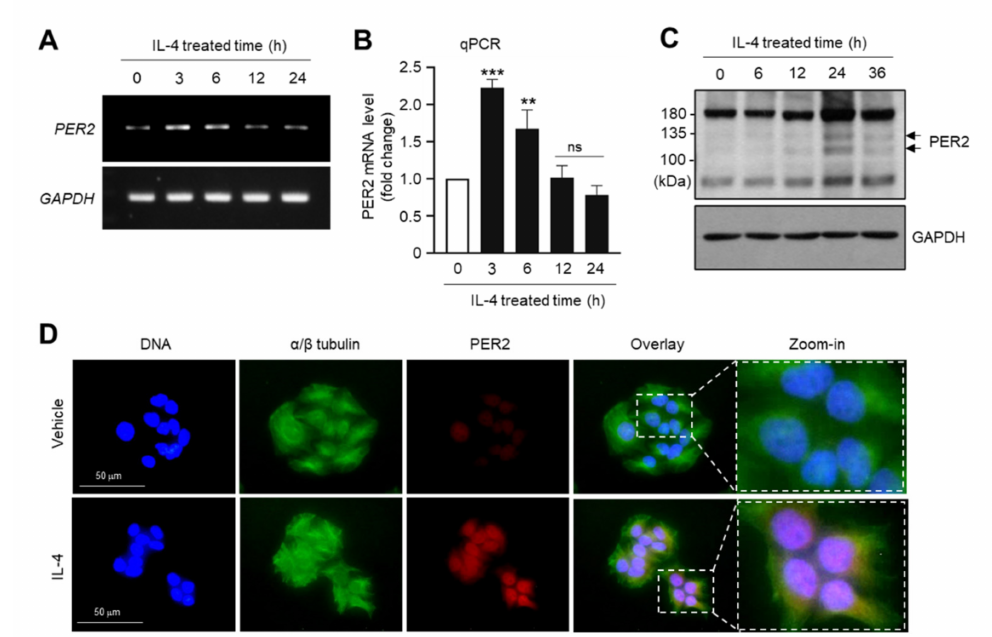
Figure 1. Effect of IL-4 on the expression of PER2. HaCaT cells were treated with vehicle (PBS) or 20 ng/mL IL-4 for various periods (0–36 h). ( A , B ) Total RNA was isolated, and the levels of PER2 mRNA were measured by RT-PCR ( A ) and qPCR ( B ). The mRNA level of GAPDH was used as an internal control. ns, not significant; ** p < 0.01; *** p < 0.001 compared to vehicle (PBS)-treated control group ( n = 3) by Sidak’s multiple comparisons test. ( C ) Whole-cell lysates were prepared and immunoblotted using anti-IL31 antibodies. GAPDH was used as the loading control. ( D ) HaCaT cells cultured on coverslips were treated with vehicle (PBS) or 20 ng/mL IL-4 for 24 h, followed by fixing and permeabilization. Immunofluorescence staining was performed using anti-PER2 and Alexa Fluor 555-conjugated secondary antibodies (red staining). α / β -tubulin was counterstained with anti- α / β tubulin and Alexa Fluor 488-conjugated secondary antibodies (green staining). Nuclear DNA was stained with 1 µ g/mL Hoechst 33258 (blue staining). Fluorescent cells were captured with an EVOSf1 fluorescence microscope. The last panel on the right is a zoomed-in view of the dotted box. Scale bars, 50 µ m. IL-4, interleukin 4; GAPDH, glyceraldehyde 3-phosphate dehydrogenase;